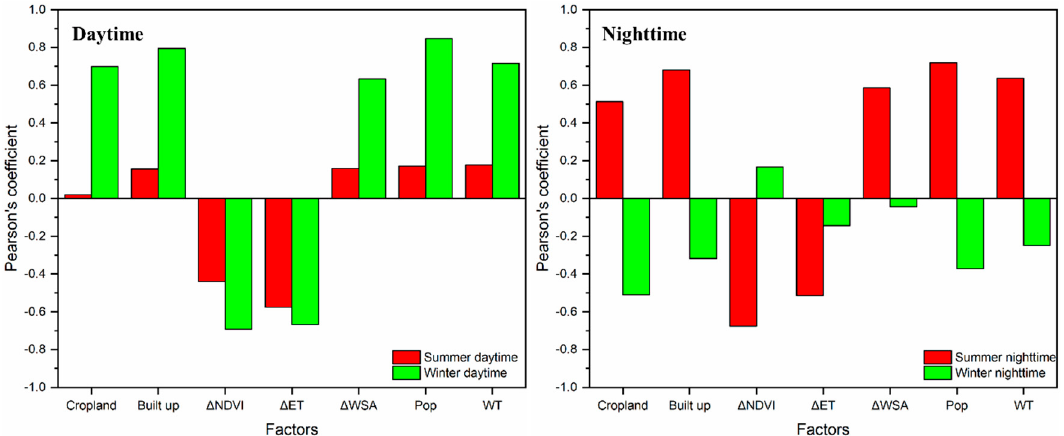
Figure 11. Pearson’s correlation between SUHII (2003–2018) and di ff erent potential drivers during Figure 11 . Pearson’s correlation between SUHII (2003–2018) and different potential drivers during daytime and nighttime, in the summer and winter daytime and nighttime, in the summer and winter season.